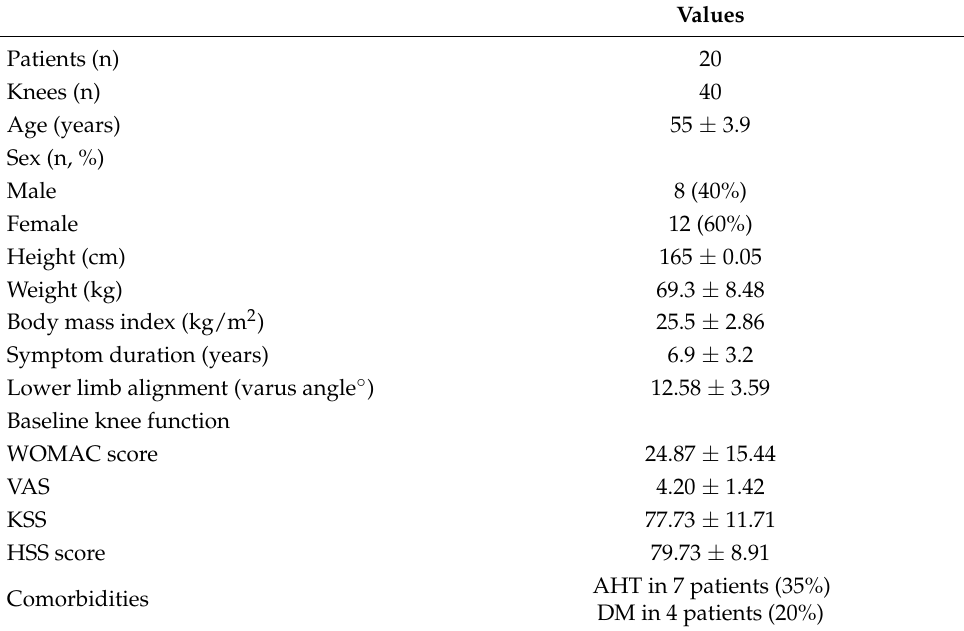
Table 1. Demographic characteristics of the